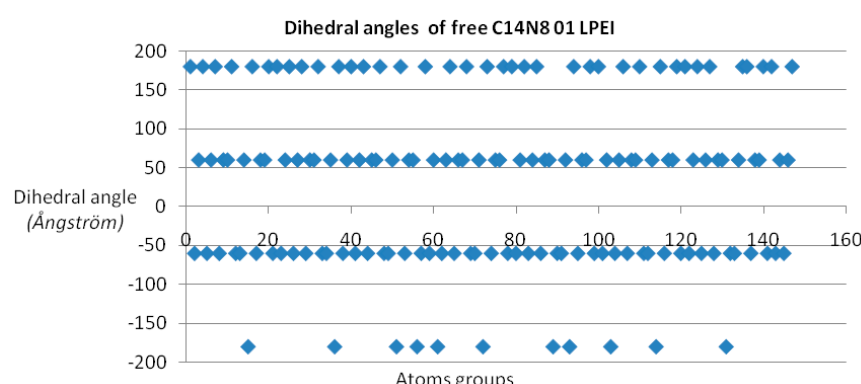
Figure 1. Dihedral angles of free linear polyethylenimine (LPEI) 01 C14N8, represented as a function of the atom groups; more details in the main text.